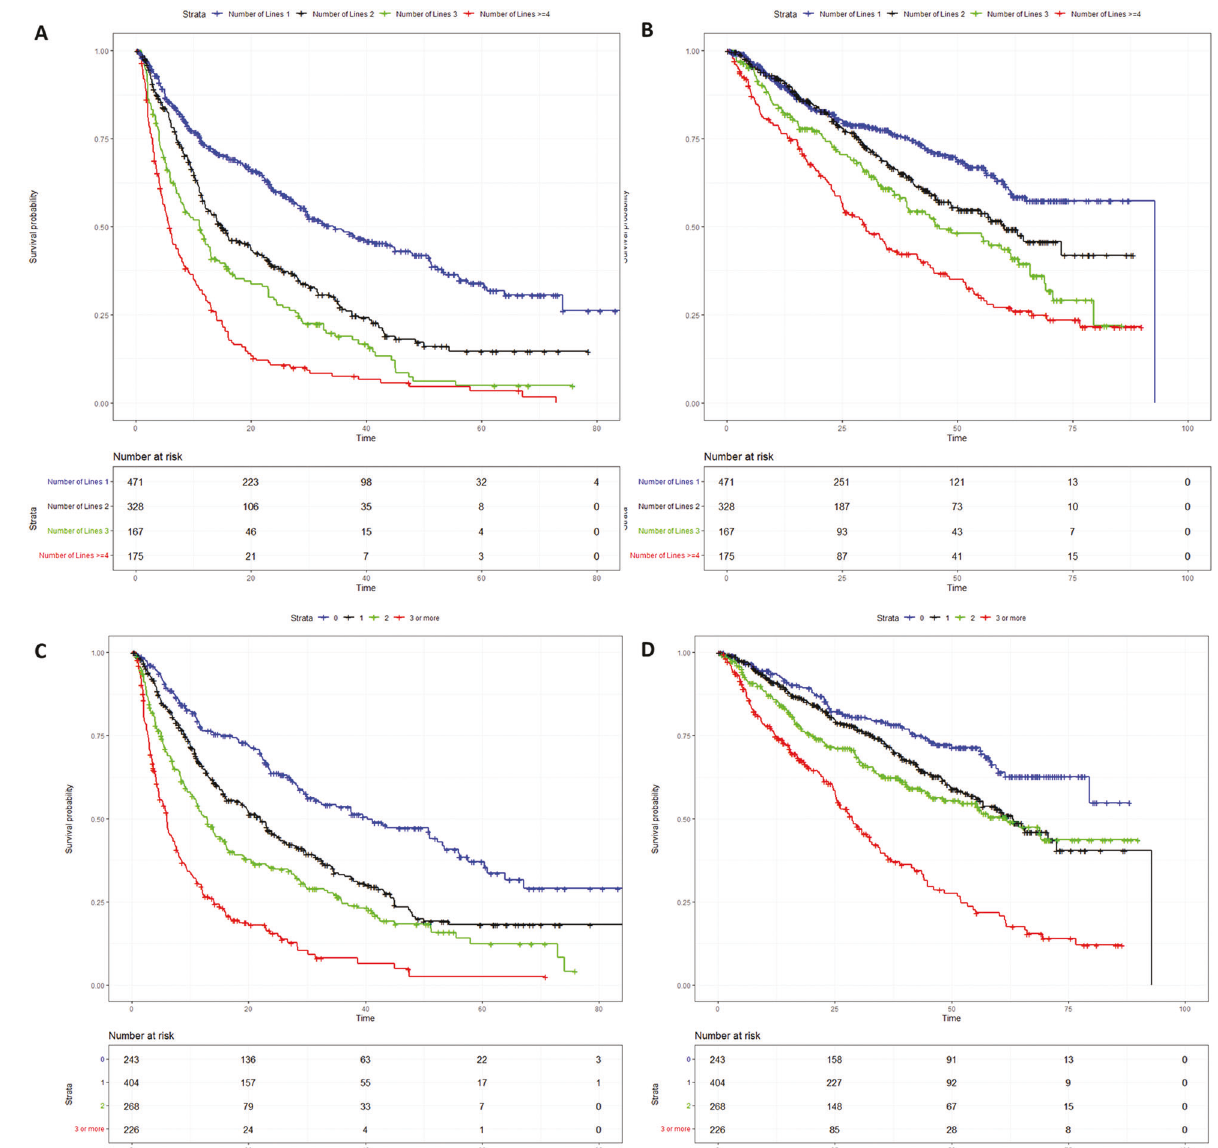
Fig. 1 Survival curves according to different classi fi cations. A Progression-free survival (PFS) by the number of prior lines of therapy. B Overall survival (OS) by the number of prior lines of therapy. C Progression-free survival (PFS) by refractoriness to the number of drug classes. D Overall survival (OS) by refractoriness to the number of drug